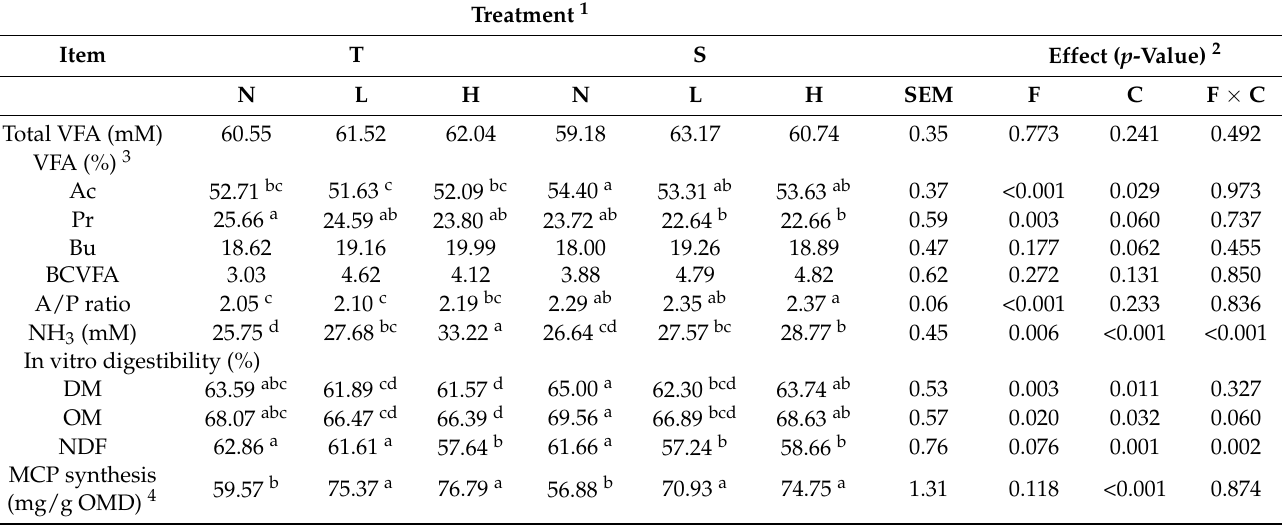
Table 3. The effect of M-CMS supplementation to diets with or without corn silage on fermentation parameters and in vitro digestibility (Experiment 1). Treatment